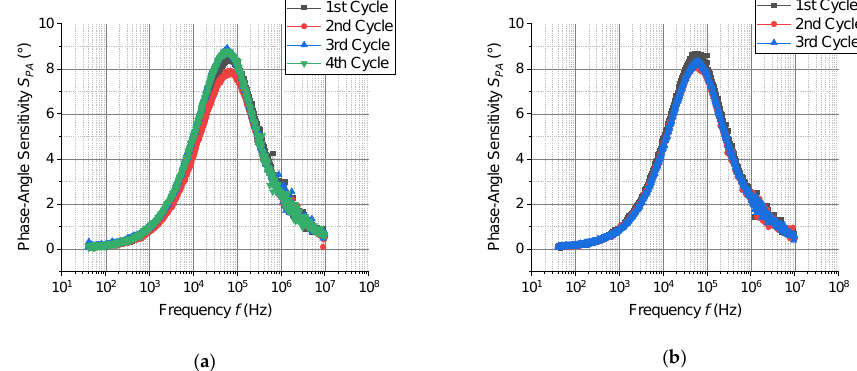
Figure 9. The dependence of phase-angle response vs. frequency for 100 ppm EtOH ( a ); 100 ppm EtOH + 100 ppm H 2 O ( b ). The reference atmosphere was synthetic air.